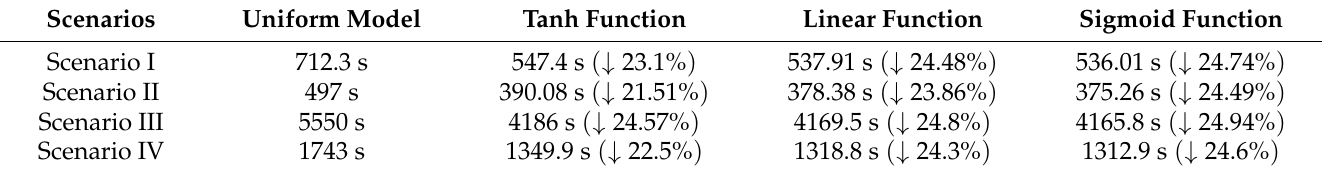
Figure 18. Adaptive velocity behavior model with linear, tanh, and sigmoid functions with a velocity corresponding to the grid cells of the map for scenario IV. Table 3. Total estimated time (in seconds) for each scenario under various models.